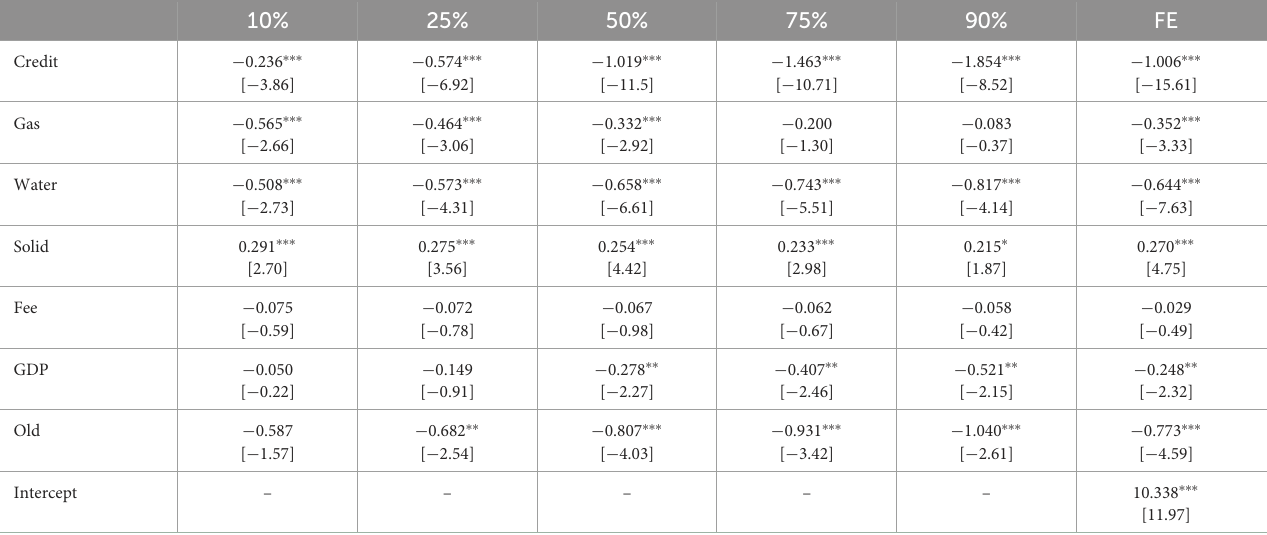
TABLE 6 Quantile regression results of green credit on health care